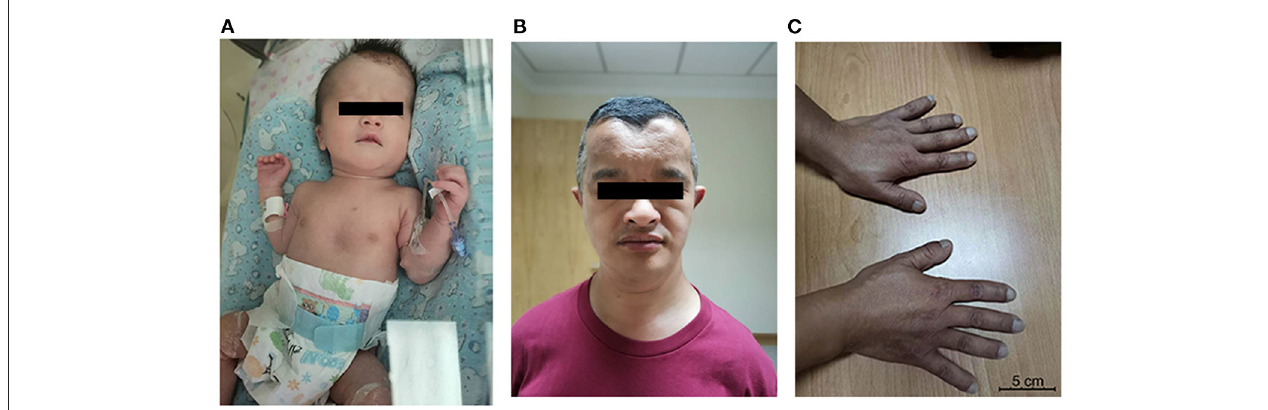
FIGURE 1 | (A) Propositus: broad forehead with open metopic suture, pectus excavatum; (B) father: mediofrontal depression, ocular hypertelorism, malar hypoplasia; (C) father’s hands: brachydactyly, brachytelephalangism, and broad